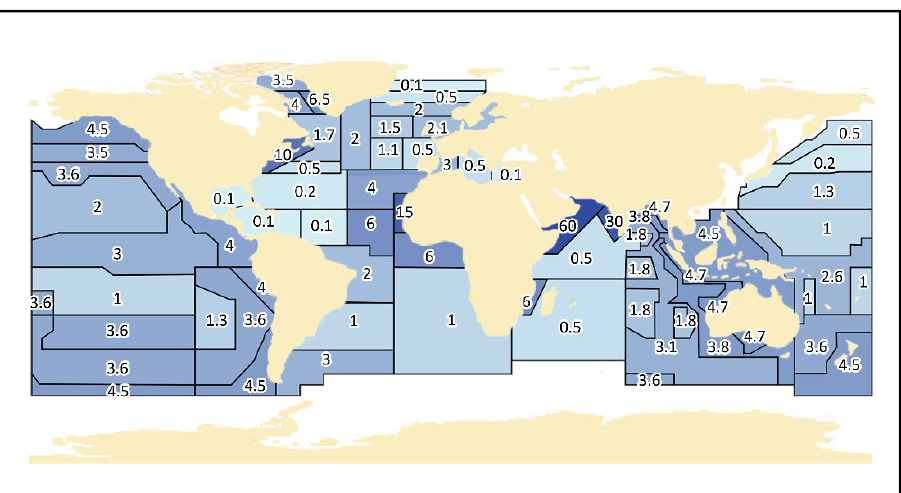
Figure 2. Biomass of mesopelagics (in g·m − 3 ) based on data in Gjøsaeter and Kawaguchi [2], with mean estimates per stratum corrected using ESRI’s ArcGIS 9.0. Light blue refers to low densities of mesopelagics (with means in g·m − 3 ), dark blue to high densities, white refers to unsampled sea areas, and yellow to land.